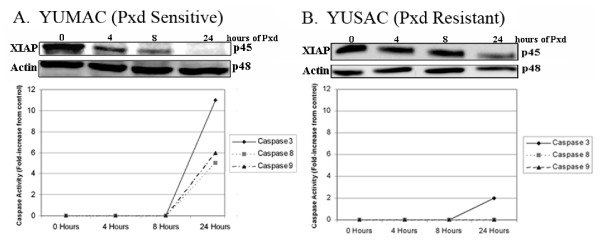
Effect of Phenoxodiol on YUMAC (A) and YUSAC2 (B) cells. Cells were treated with a single dose of Phenoxodiol (10 μg/mL) for varying time points (0, 4, 8, and 24 hours). XIAP and caspase-2 expression were determined by western blot analysis. Caspase-3, -8, and -9 activities were determined by the Caspase-Glo 3, 8, and 9 assays, respectively.